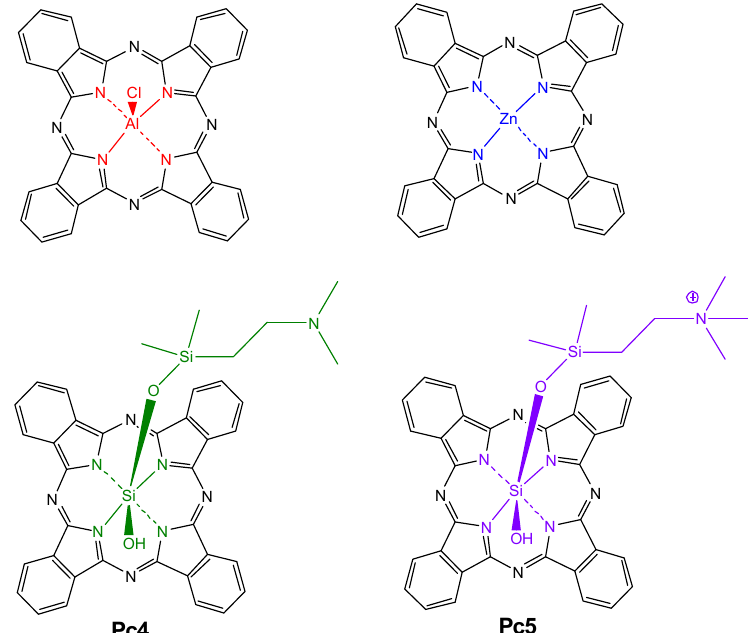
Figure 11. Molecular structures of the Al(III), Zn(II), and Si(IV) phthalocyanines used against Leishmania amazonensis by Zhao, Dutta, Escobar, et al. [103,120,121].